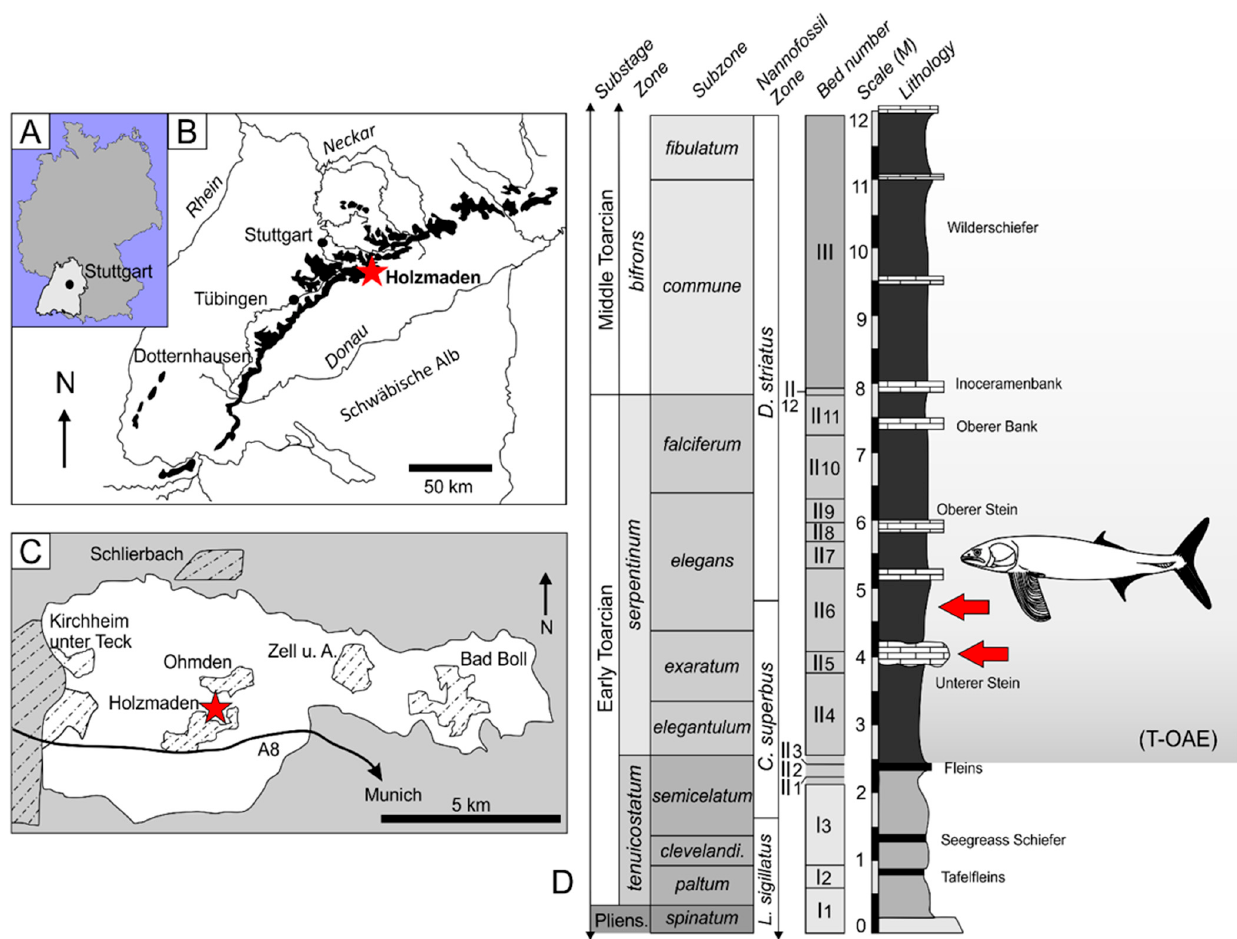
Figure 1. Locality maps and stratigraphic column of the Posidonienschiefer Formation: ( A ) Map of Germany with the state of Baden-Württemberg highlighted. ( B ) Stylized map of Baden-Württemberg, showing regional outcrops of the Posidonienschiefer Formation (black) in the region. The study locality of Holzmaden is indicated with a star. ( C ) Simplified map of the Holzmaden region, with the studied locality, within the town of Holzmaden, indicated with a star (modified from Maxwell et al. [34]). ( D ) Stratigraphic log of the Posidonienschiefer Formation at Holzmaden, with the two occurrences of the new pachycormid in beds II5 ( exaratum subzone) and II6 ( elegans subzone) indicated by the red arrow icons. Log redrawn and modified from Maxwell and Vincent